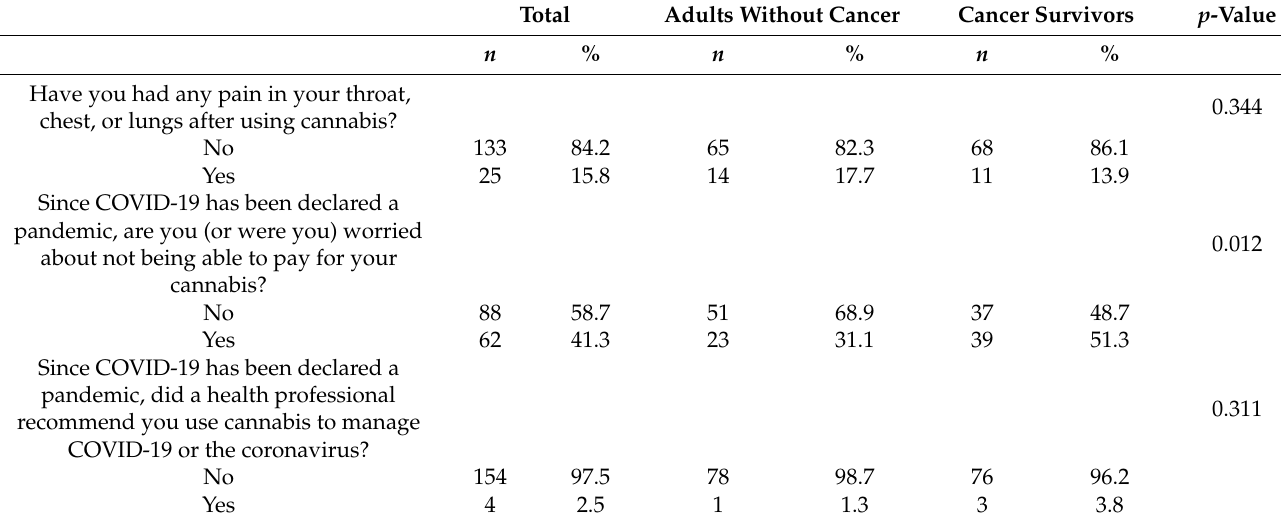
Table 3. Cannabis Use Patterns During the COVID-19 Pandemic Among the COVID-19 Cannabis Health